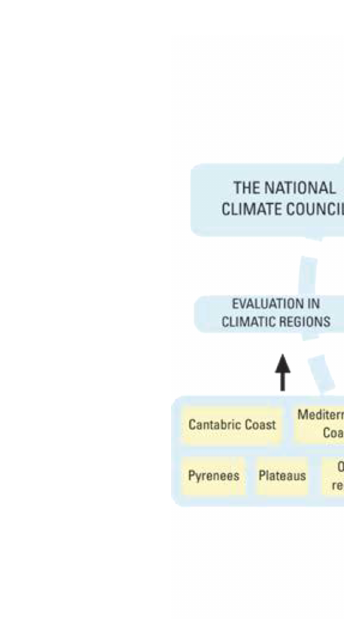
Figure 1. Structure of the National Climate Change Adaptation Plan. Table 2. Regionalized projections of temperature ( T max & T min) and precipitation obtained by statistical methods (analog and regression) and dynamical regionalisation (EURO-CORDEX) based on AR5-IPCC results. For analog and regression methods, numbers indicate the number of driving GCMs in each case. For CORDEX, number refers to the number of different GCM/RCM combinations. TEMPERATURE PRECIPITATION Scenario Analog Regression CORDEX Total Analog Regression CORDEX Total RCP8.5 14 19 10 43 17 19 10 46 RCP6.0 6 7 13 14 RCP4.5 13 15 10 38 18 15 10 43 Total 33 41 20 94 42 41 20